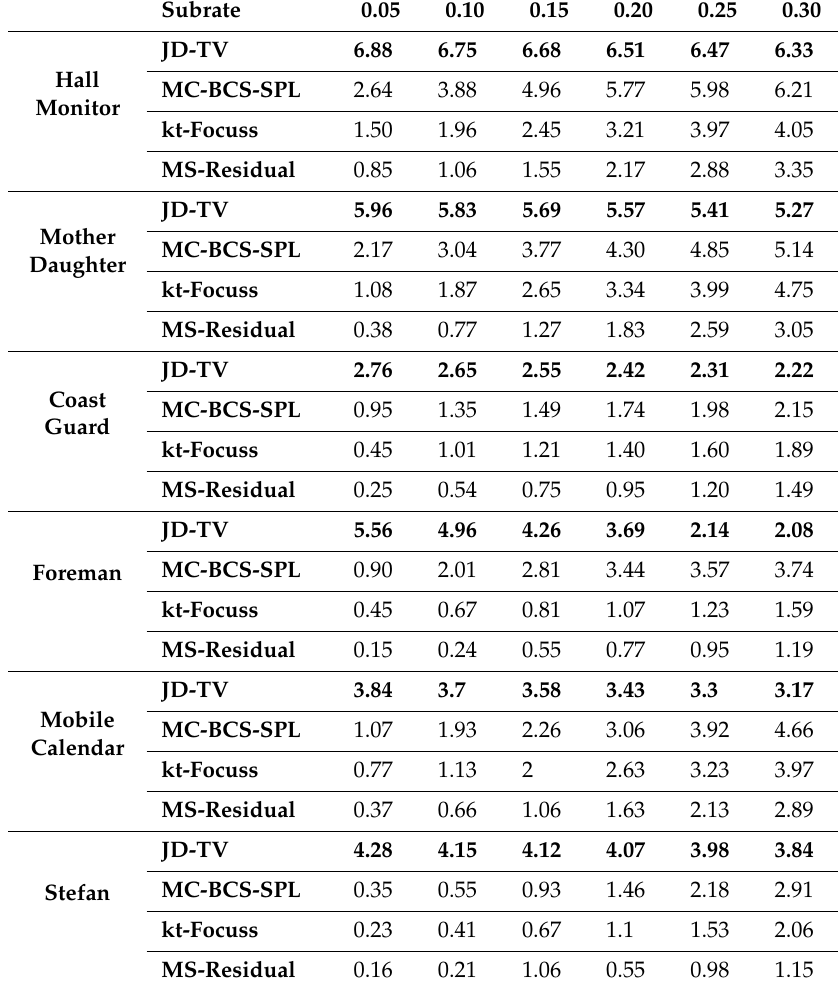
Table 7. Average PSNR gain (dB) analysis of the proposed JD with conventional CS schemes for various video